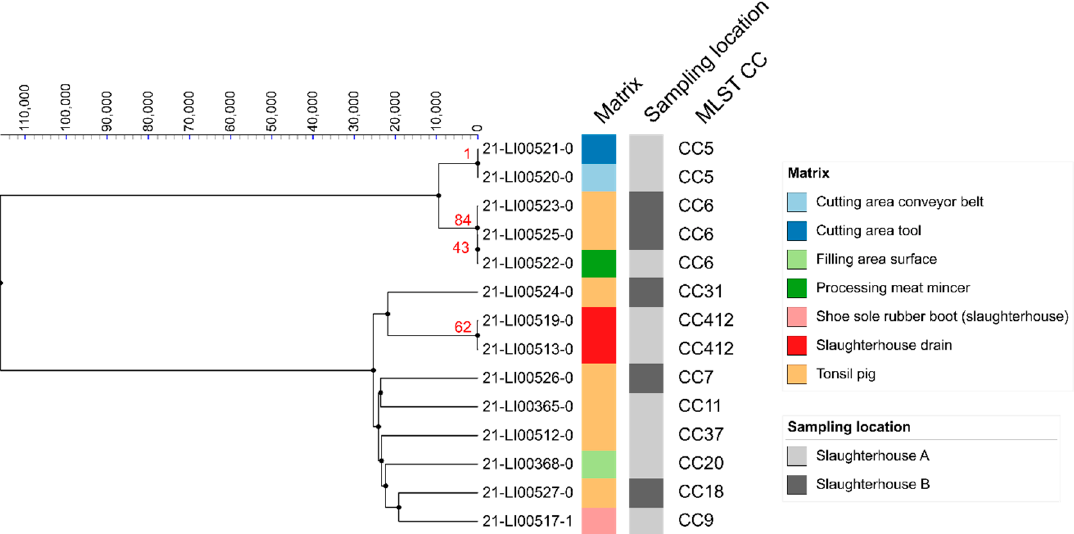
Figure 1. Clustering of 14 L. monocytogenes isolates found in pigs and the slaughterhouse environment in a linkage tree with differences of less than 1,000 SNPs indicated.